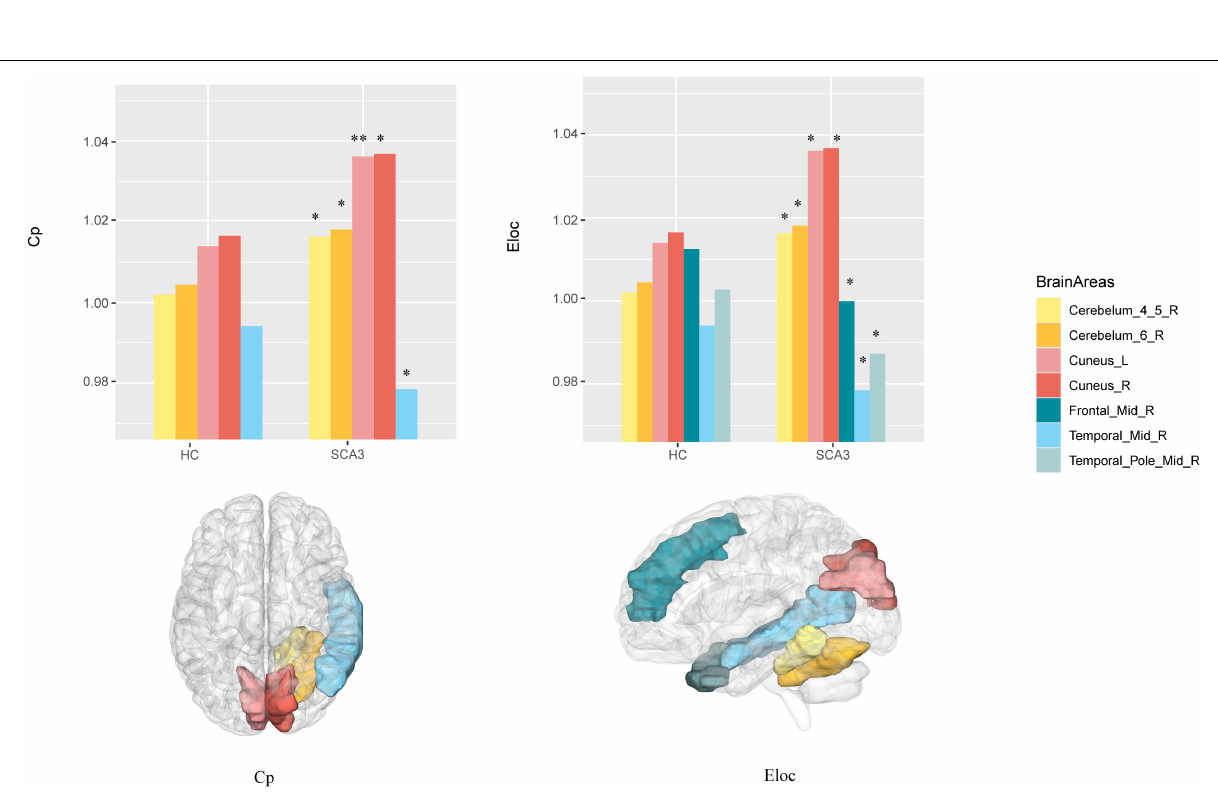
Frontiers in Aging Neuroscience |